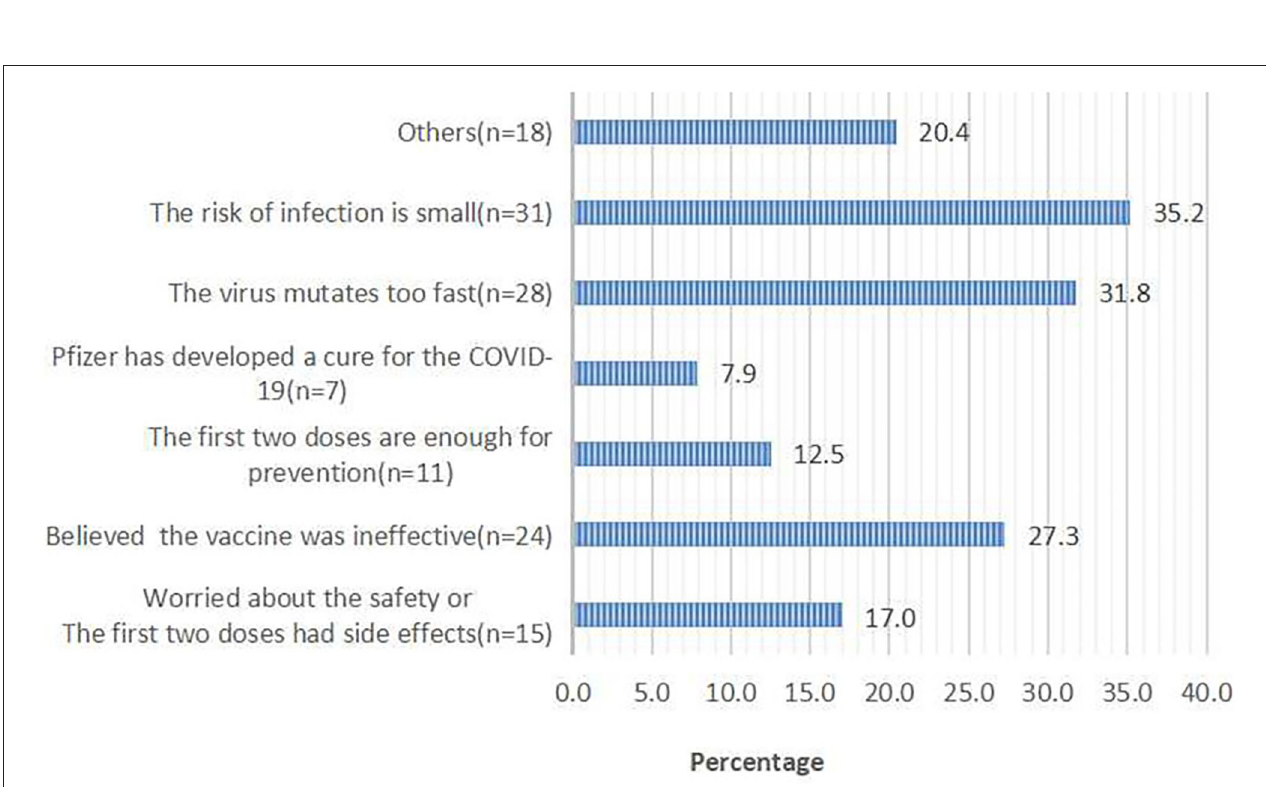
FIGURE 2 | Reasons for hesitancy in taking the third booster dose; responses from 102 participants who said they would refuse the booster dose.